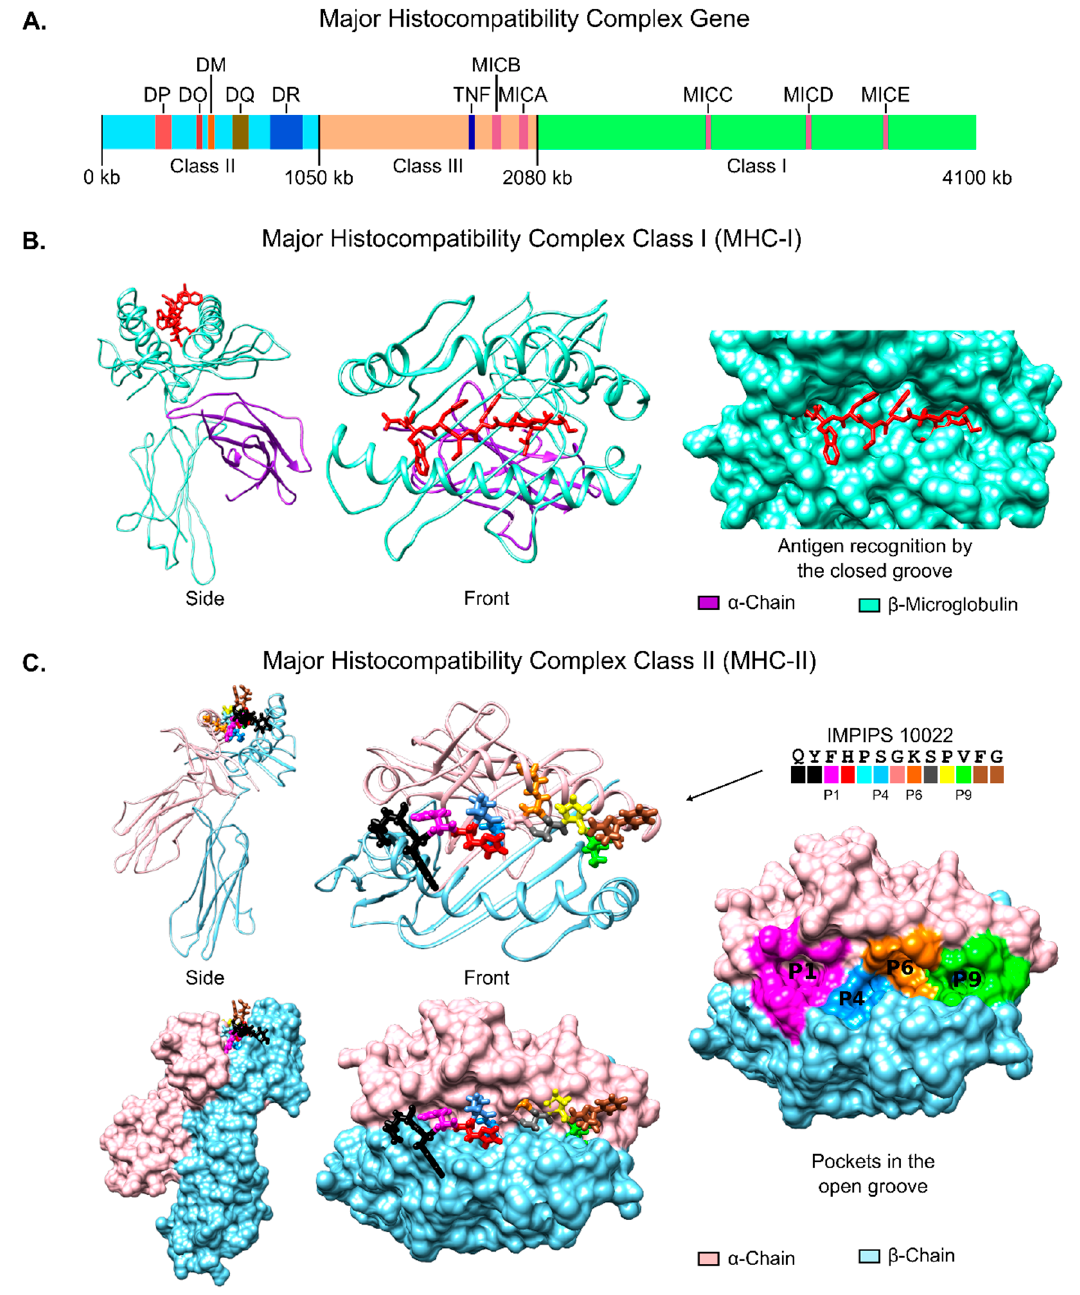
Figure 3. Major histocompatibility complex. ( A ) Schematic representation of the gene encoding the three MHC classes, with the most important proteins roughly located; ( B ) Major histocompatibility complex class (MHC) I ribbon and surface structure (based on PDB code 5MEP) displaying the α -chain, the β -microglobulin as well as the closed groove for peptide antigen recognition [166]; ( C ) MHC class II ribbon and surface structure (based on PDB code 1A6A [167] displaying the α - and β -chains and the open groove for peptide antigen (IMPIPS 10022, sequence and colour code given) recognition [168] coloured according to the same color code for pockets P1, P4, P6 and P9.